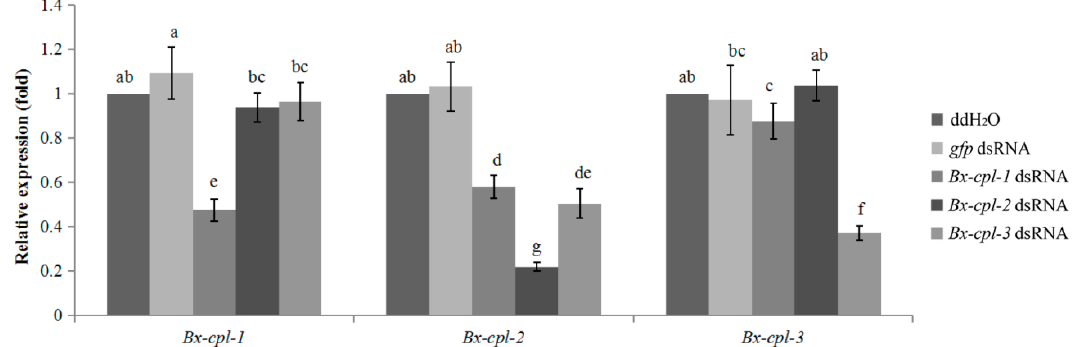
Figure 6. Relative expression levels of Bx-cpl s after treatment with Bx-cpl double-stranded RNA (dsRNA). The bars indicate standard errors, and different letters indicate significant differences ( p < 0.05) among treatments: no dsRNA control (ddH 2 O), green fluorescent protein gene ( gfp ) dsRNA control, and each Bx-cpl dsRNA.